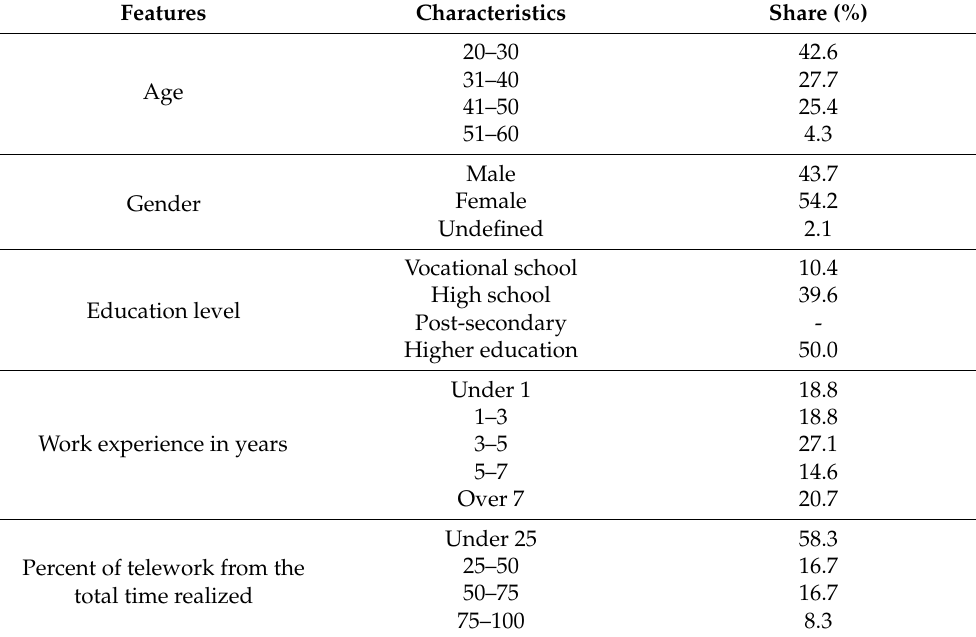
Table 3. Sociodemographic particularities of the execution staff from